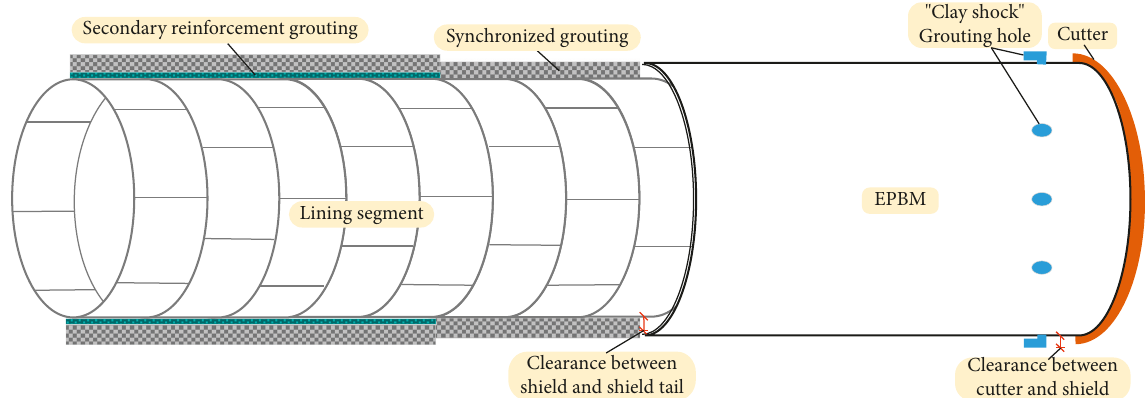
Figure 3: Schematic diagram of formation subsidence control